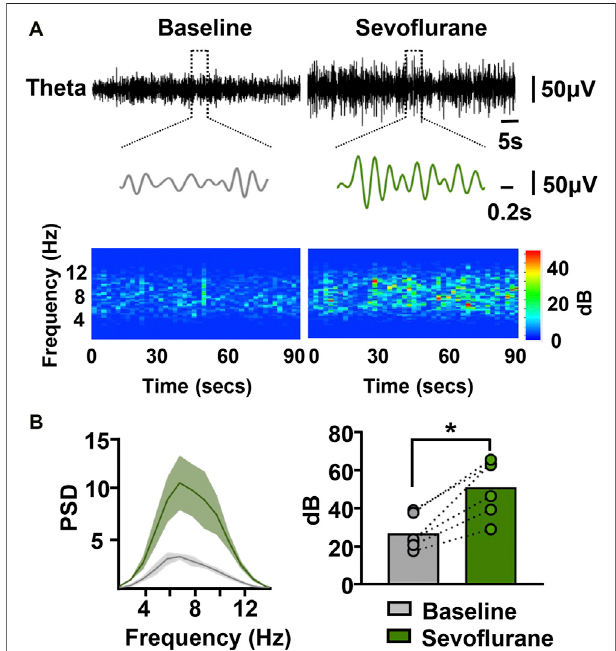
FIGURE3| Sevo fl uraneatmemory-damagingconcentrationsenhances hippocampal theta oscillations in mice. (A) Examples of theta waves and representative spectrograms recorded at immobile status prior to and during sevo fl urane anesthesia. The data were digital- fi ltered to 4 – 12 Hz. (B) Representative power spectrum in the theta frequency band (left) obtained from a sevo fl urane-anesthetized mouse. Solid lines represent mean values, and shaded regions represent 95% CIs. Sevo fl urane signi fi cantly increased the power in the theta band (right) . N (cid:2) 6/group. Values are shown as the mean ± SEM; paired t -tests. * p <